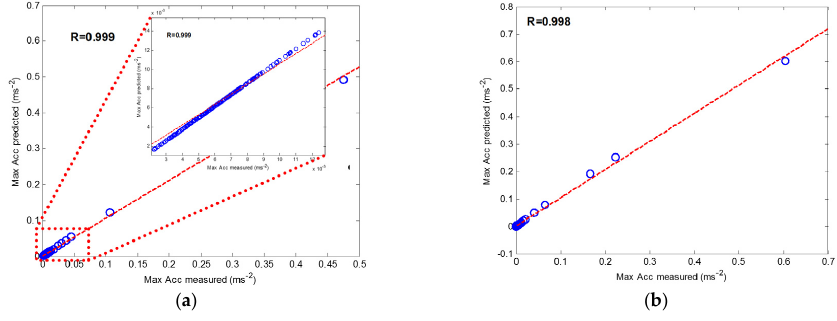
Figure 8. Predicting the effect of cross-correlation between maximum values of accelerations by using quadratic polynomials. ( a ) 400 km/h; ( b ) 406 km/h.